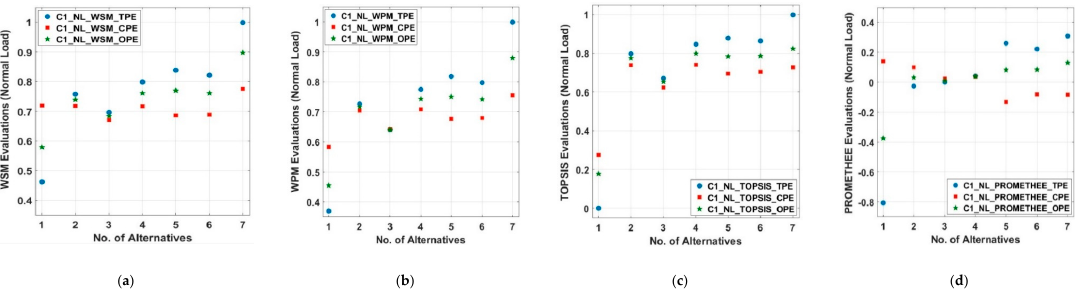
Figure 5. MCDM evaluations for C1_NL in 33-bus MDN: ( a ) weighted sum method (WSM) scores; (b) weighted product method (WPM) scores; ( c ) technique for order preference by similarity to ideal solution (TOPSIS) scores; ( d ) preference ranking organization method for enrichment of evaluations (PROMETHEE) scores.